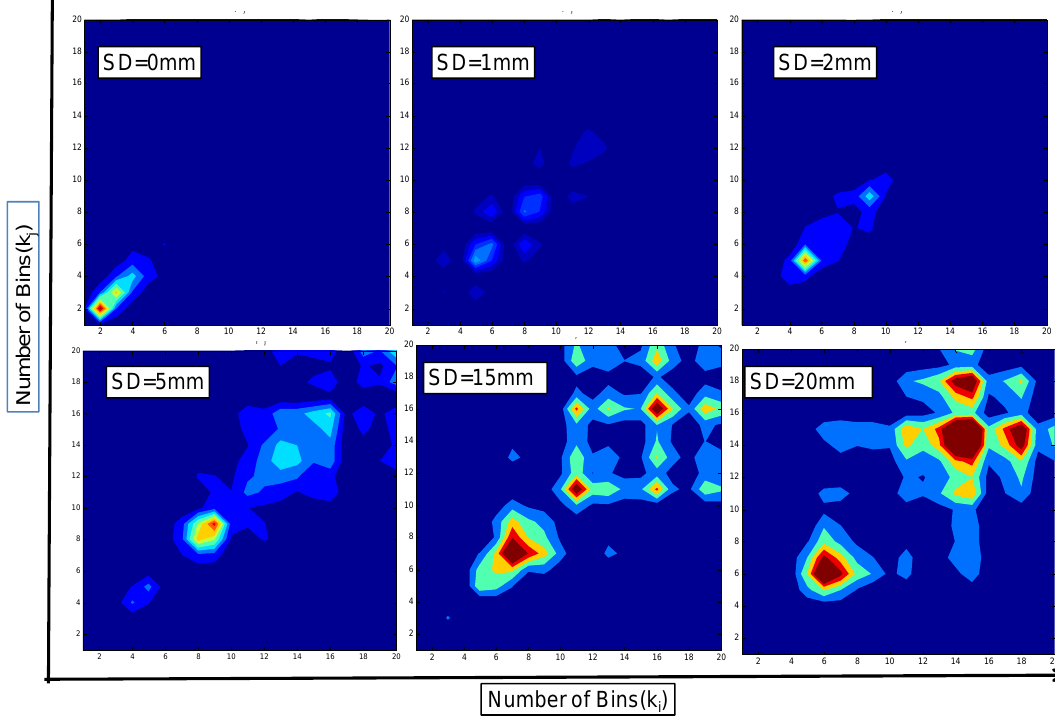
Fig. 5. Assortative networks in parallel-friction networks: joint degree distribution evolution through the successive displacements of the rock joint (parallel profiles) from shear displacement 0mm to 20mm.